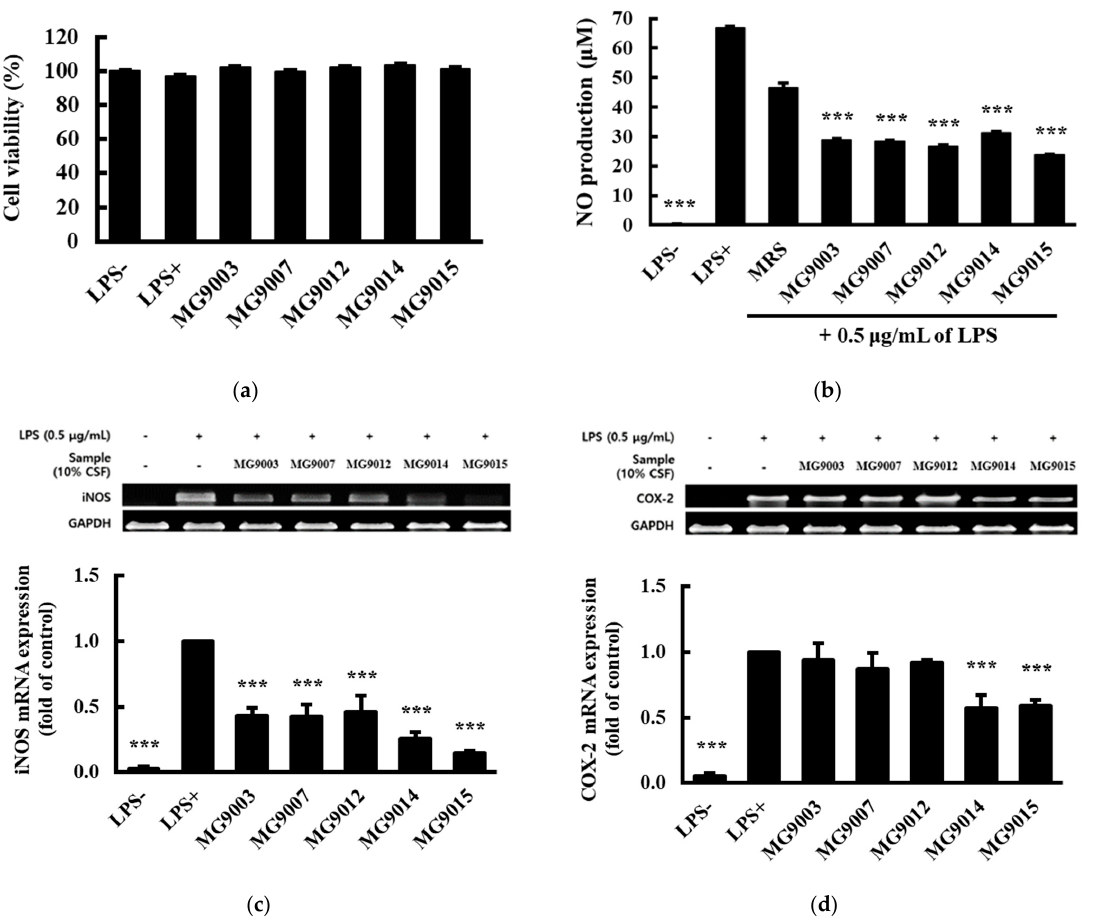
Figure 4. Effects of cell-free supernatants (CFSs) on cell viability, nitric oxide (NO) production, and iNOS and COX-2 expression. ( a ) Measurement of cell viability through MTT assay. ( b ) Inhibition of NO production in LPS-induced RAW 264.7 cells treated with 10% ( v / v ) CFSs of selected strains. Levels of ( c ) iNOS and ( d ) COX-2 mRNA expression were determined by RT-PCR. Glyceraldehyde-3-phosphate dehydrogenase (GAPDH) was used as a housekeeping gene to quantify relatively all groups. Values represent the mean ± SEM ( n = 3). MG9003: E. faecium , MG9007: E. faecium , MG9012: L. reuteri , MG9014: L. fermentum , MG9015 : P. pentosaceus . *** p < 0.001, compared to the LPS treated group (LPS+), indicates statistical significance.